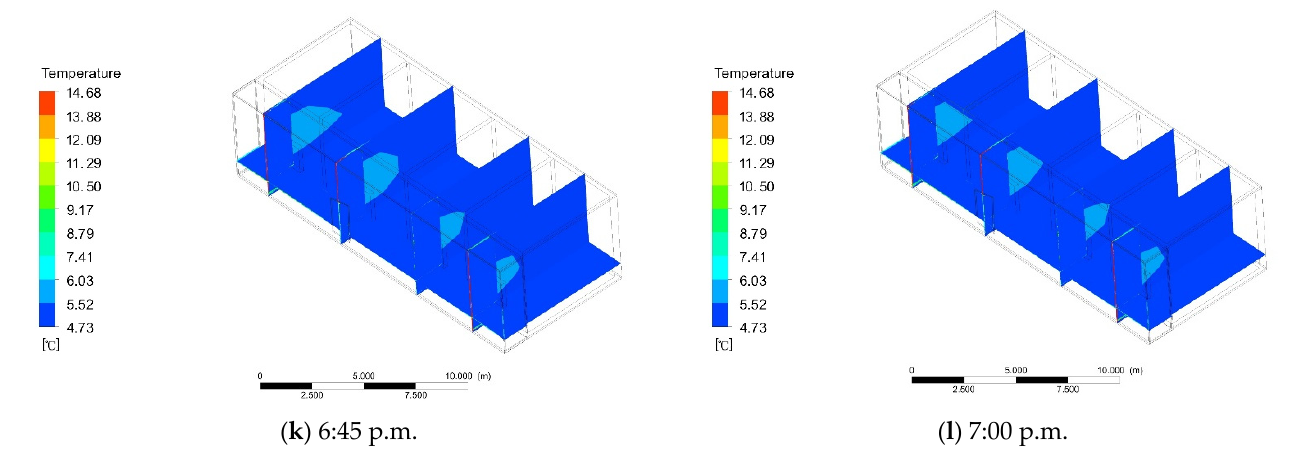
( k ) 6:45 p.m. ( l ) 7:00 p.m. Figure 13. ( a ) At 9:10 a.m. the temperature of the new system (without WSR). ( b ) At 9:20 a.m. the temperature of the new system (without WSR). ( c ) At 9:30 a.m. the temperature of the new system (without WSR) ( d ) At 9:34 a.m. the temperature of the new system (without WSR). ( e ) At 9:45 a.m. the temperature of the new system (without WSR). ( f ) At 9:55 a.m. the temperature of the new system (without WSR). ( g ) At 10:10 a.m. the temperature of the new system (without WSR). ( h ) At 10:20 a.m. the temperature of the new system (without WSR). ( i ) At 6.00 p.m. the temperature of the new system (without WSR). ( j ) At 6.24 p.m. the temperature of the new system (without WSR). ( k ) At 6.45 p.m. the temperature of the new system (without WSR). ( l ) At 7.00 p.m. the temperature of the new system (without WSR).